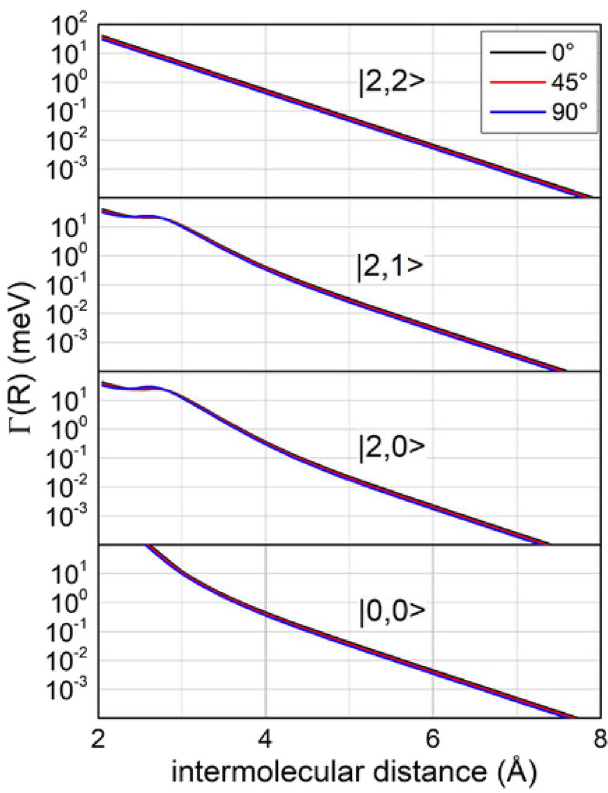
Figure 2. State-to-state Γ components obtained for different molecular orientation and plotted as a function of the intermolecular distance R. The quantum state | J , Ω > of Ne * reagent is indicated in the Figure while the ionic product N 2 + is formed in the ground electronic state 2 Σ g + . Note also that, because of the symmetry of atomic and molecular orbital involved in the precursor state, | 2, 2 > reacts exclusively by an indirect mechanism (see